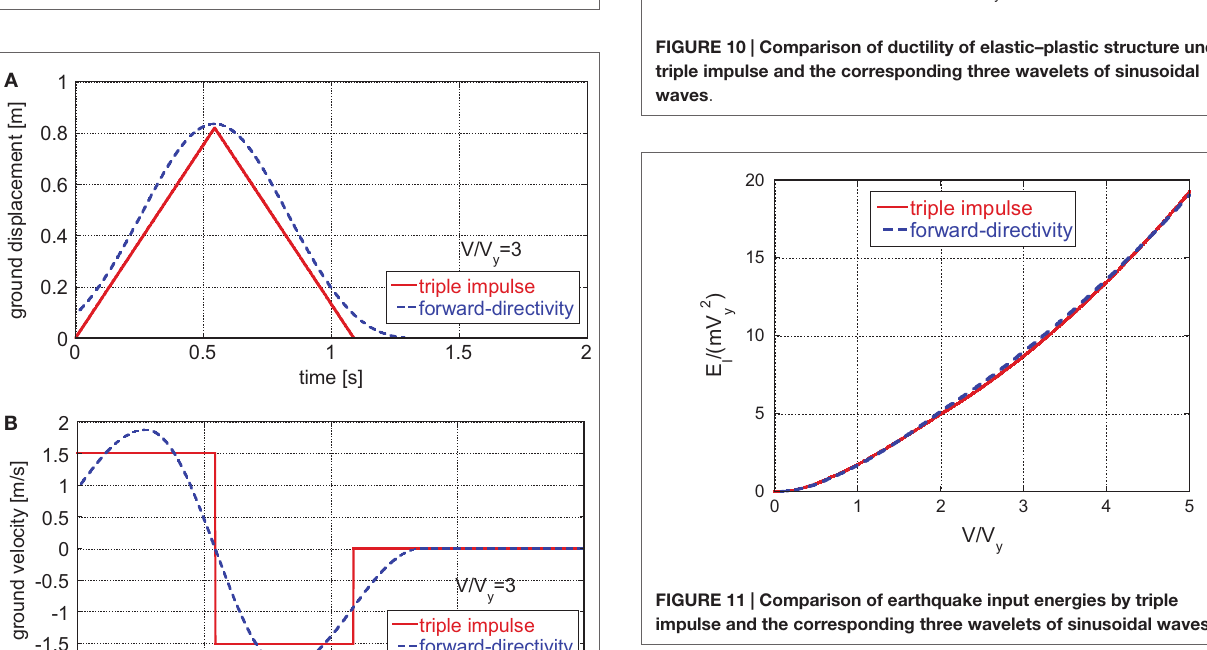
FigUre 8 | adjustment of input level of triple impulse and the corresponding three wavelets of sinusoidal waves based on Fourier amplitude equivalence